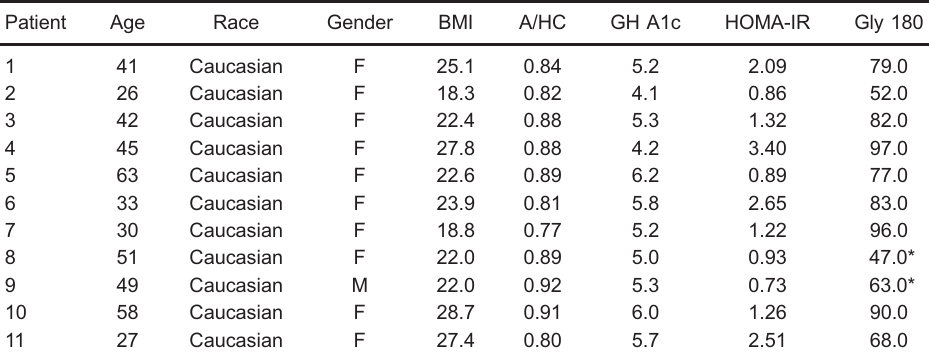
Table 1. Individual characteristics of the 11